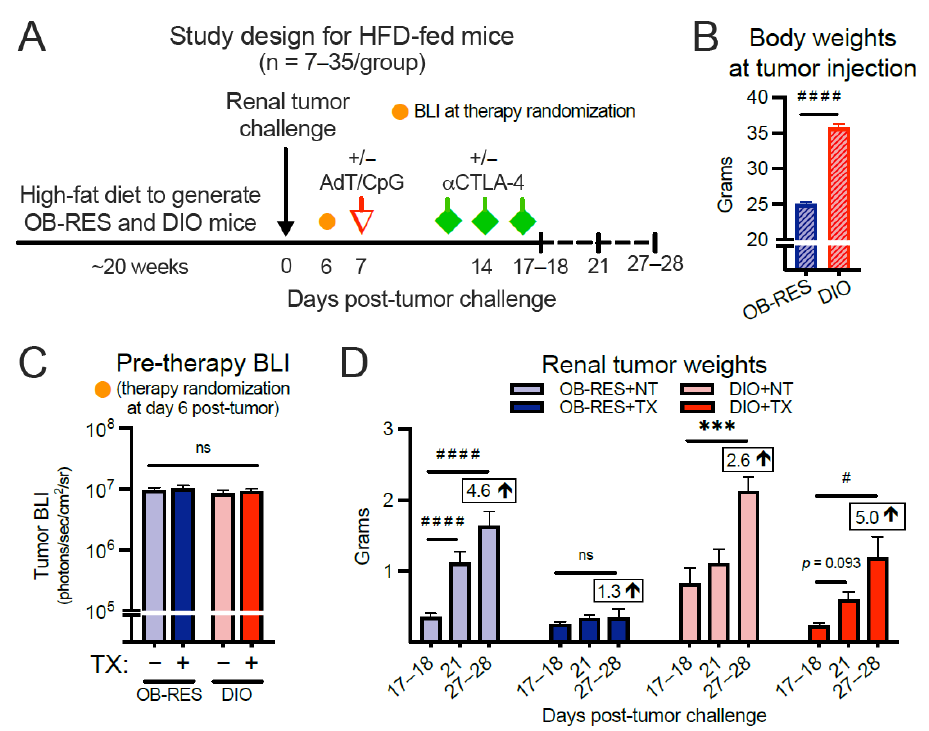
Figure 2. Therapy-treated obese-resistant (OB-RES) mice have a sustained reduction in tumor growth over time, whereas therapy-treated diet-induced obese (DIO) mice experience an acute response followed by tumor outgrowth. ( A ) Experimental design. ( B ) Body weights prior to tumor injection. ( C ) Primary tumor bioluminescence (BLI) prior to therapy administration. ( D ) Tumor growth over time within each treatment group. Data from n = 2–5 independent experiments per time point. Fold change values at day 27–28 compared to day 17–18 value. * denotes parametric and # denotes non-parametric test. # p < 0.05, *** p < 0.001, #### p < 0.0001. ns: non-significant, NT: no therapy, TX: AdT/CpG+αCTLA-4.